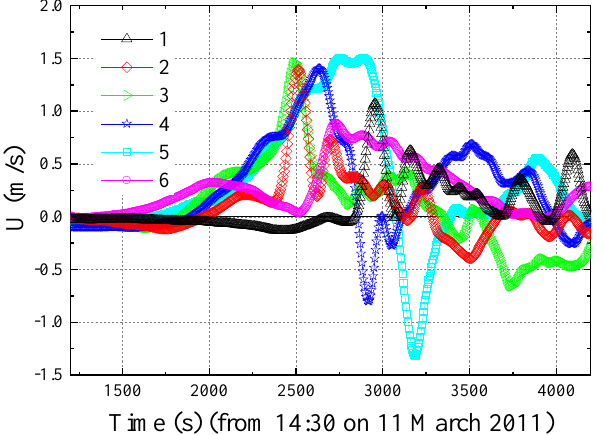
where U ( t ) is the flow velocity, η ( t ) is the water surface elevation, h is the still water depth, and g is the gravitational acceleration. Figure 2 shows the flow velocity results from Equation (1) for six stations, which indicate a highly irregular waveform.